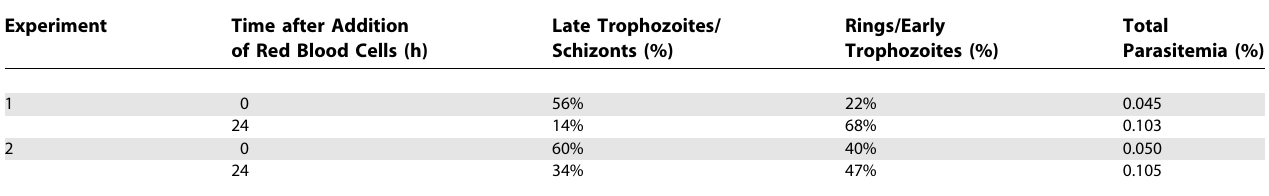
Table 1. Invasion of Human Red Blood Cells by P. vivax In Vitro Experiment